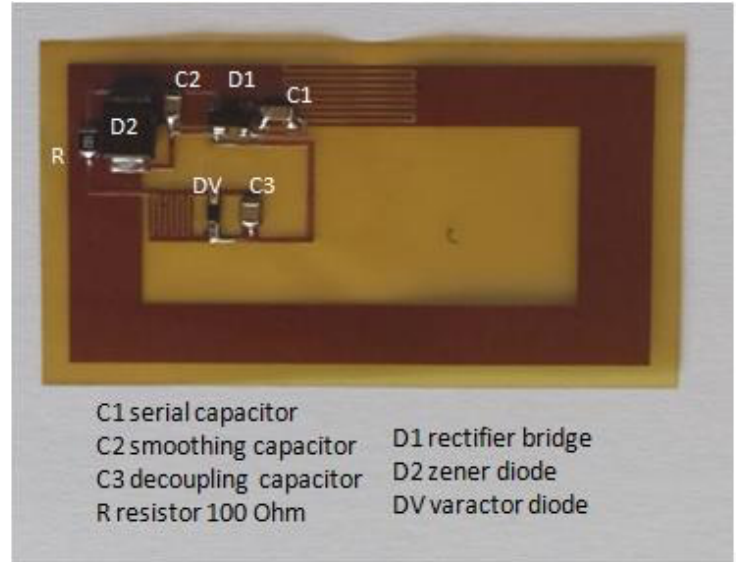
Figure 9. Prototype of the sensor tag coupled to the rectifying circuit.